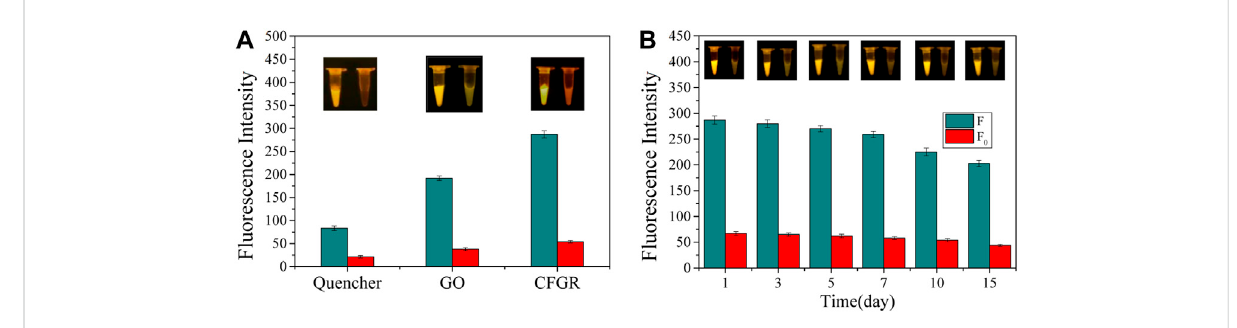
FIGURE 10 (A) Fluorescence intensity of the quencher group, GO, and CFGR. (B) The change in fl uorescence intensity with days. (F: The fi nal value of the fl uorescence intensity,